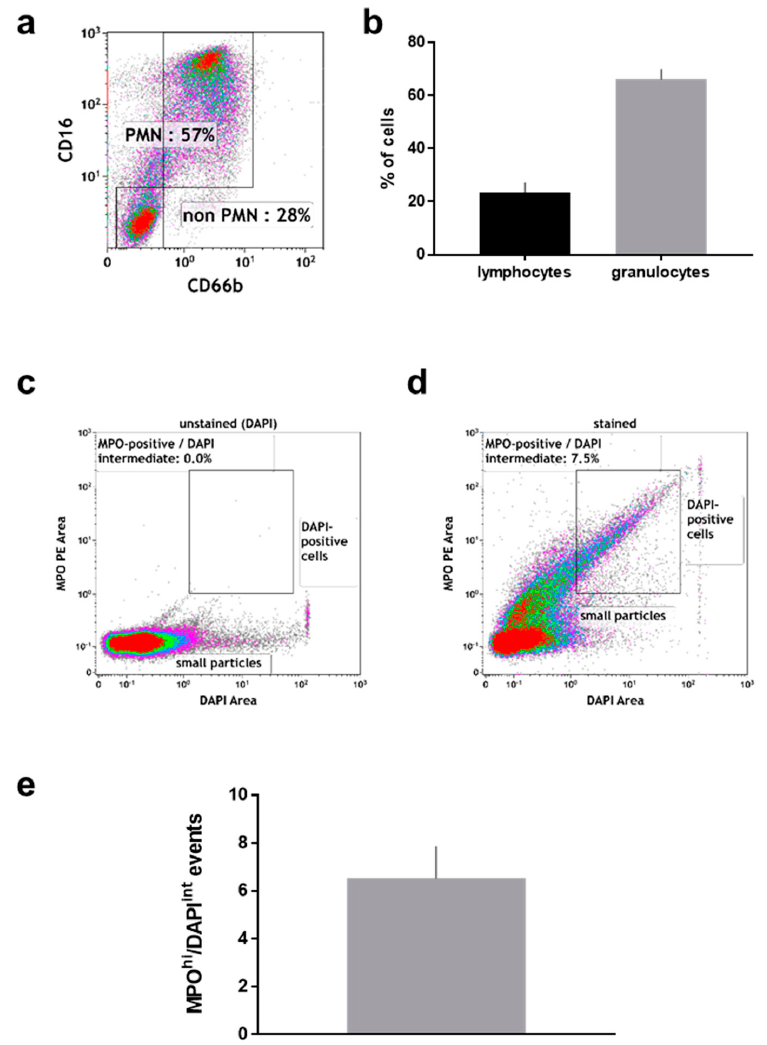
Figure 3. Flow cytometric analysis of cell pellets derived from manually removed wound material. ( a ) representative dot plot and ( b ) percent of CD16 + /CD66b + (neutrophils) and CD16 − /CD66b − cells among CD45 + /DAPI + cells; ( c ) pelleted material stained with DAPI only; ( d ) pelleted material stained against DAPI and MPO; ( e ) quantification of events staining positive for MPO and intermediate for DAPI. Data are from 6–8 patients.